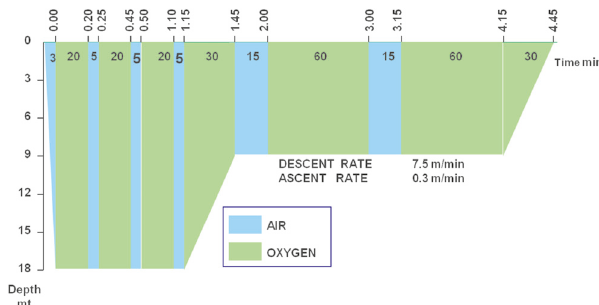
Figure 1: US Navy decompression Table